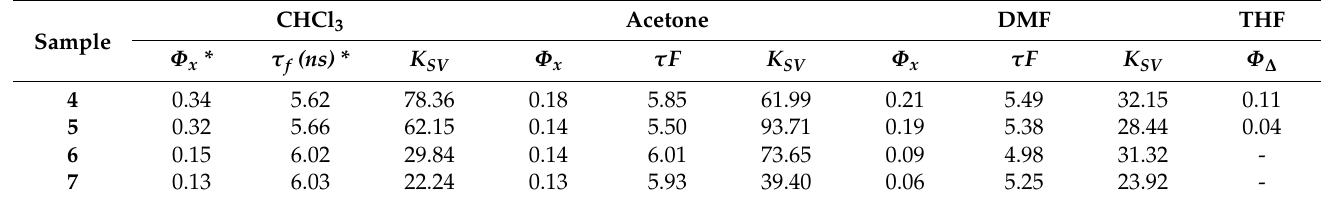
Table 2. Photophysical values of the synthesized metallated and metal-free phthalocyanines ( 4 – 7 ) in CHCl 3 , acetone, and DMF. Figure 3. The dilution of compound 6 in acetone solution at the concentration range of 5.58 × 10 −6 ÷ 1.9 × 10 −6 mol/L (red curve—initial spectrum; green curve—final spectrum).